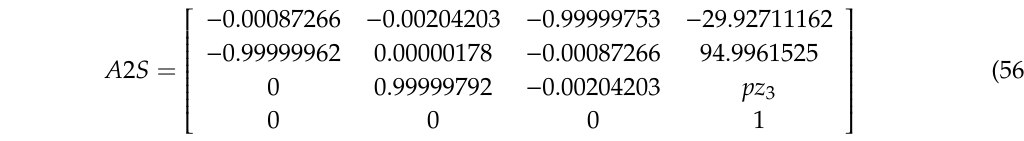
Figure 15. Scanner with camera and two laser light projectors.